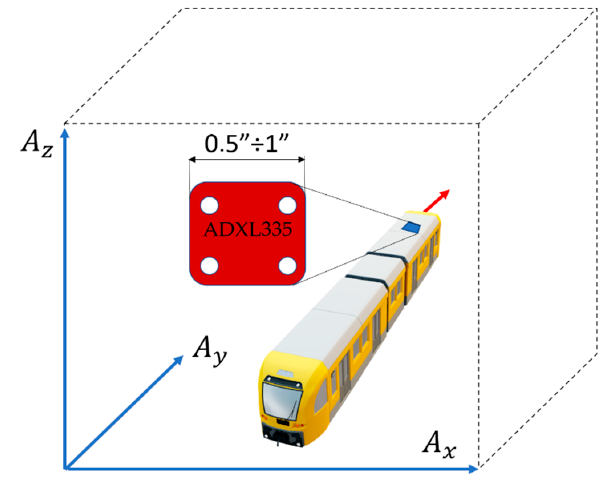
Figure 3. Small-size ADXL335 accelerometer with axes of acceleration sensitivity.